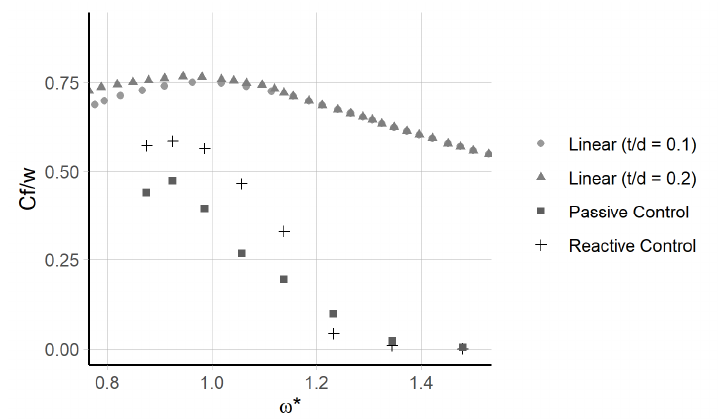
Figure 12. Capture factor against the non-dimensional wave frequency for reactive and passive control strategies using linear and nonlinear approach. The linear theory results are for damping control systems (adapted from [28]).